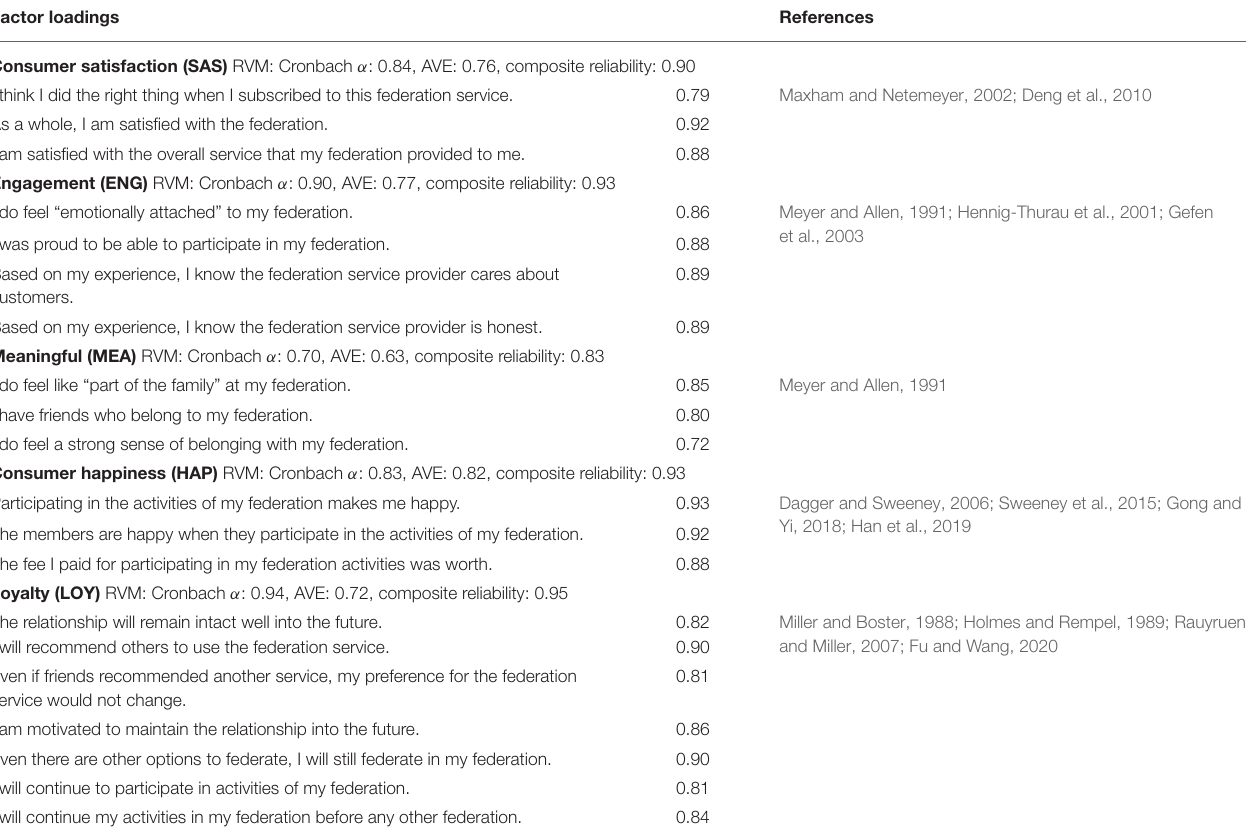
TABLE 1 | Constructs, items, factor loading, reliability, and validity. Factor